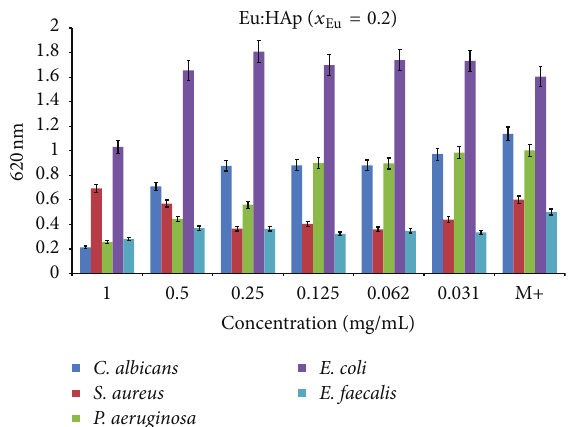
Figure 6: Antimicrobial activity of as-prepared Eu:HAp samples = 0.2 ) on E. coli ATCC 25922, Pseudomonas aeruginosa 1397, ( 𝑥 Eu Staphylococcus aureus 0364, Enterococcus faecalis ATCC 29212, and Candida albicans ATCC